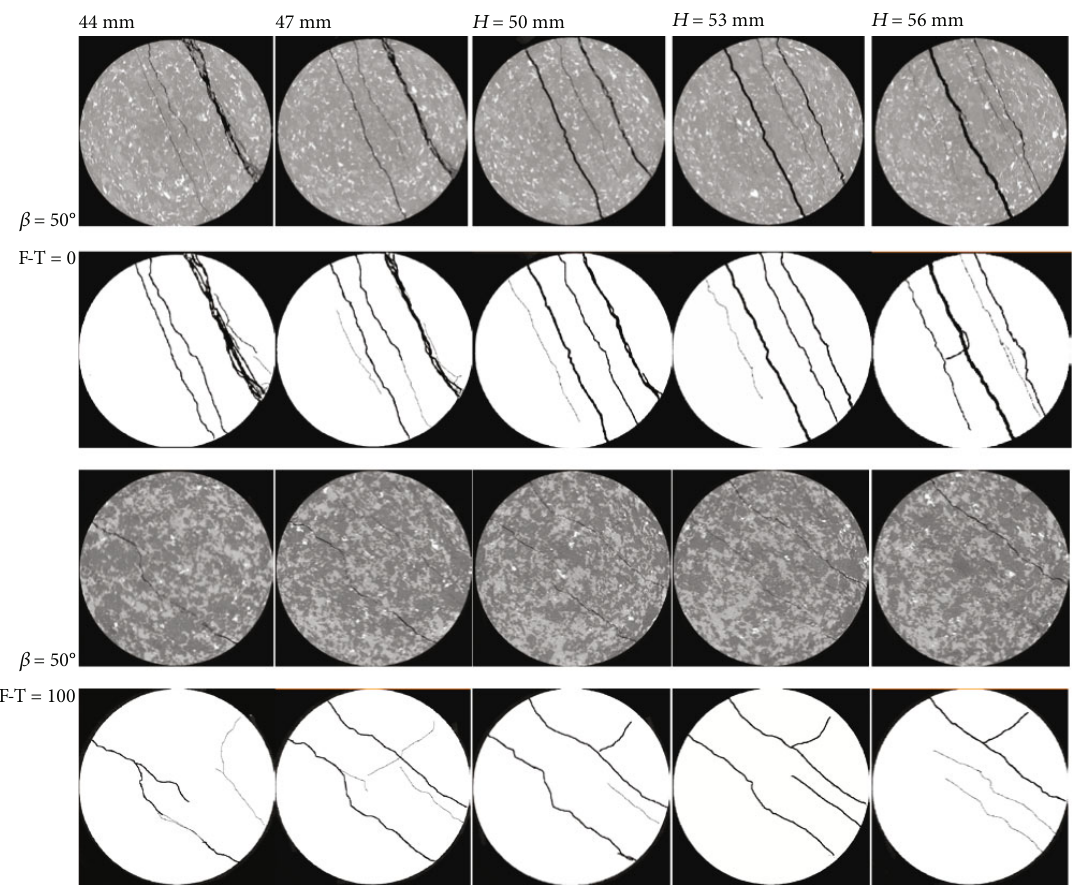
Figure 13: X-ray CT reconstruction images and crack pattern for the sample having approach an angle of 50 ° subjected to 0 and 100